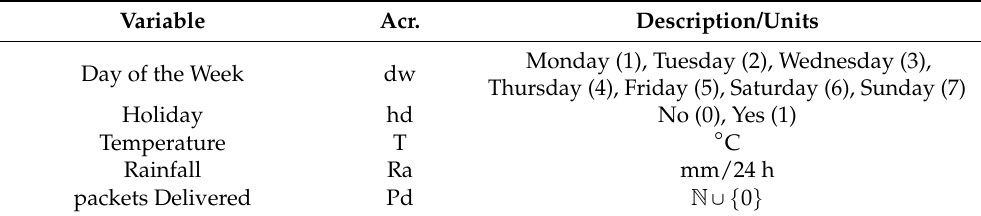
Table 4. Variables involved in the Azuqueca post packets delivered prediction problem.